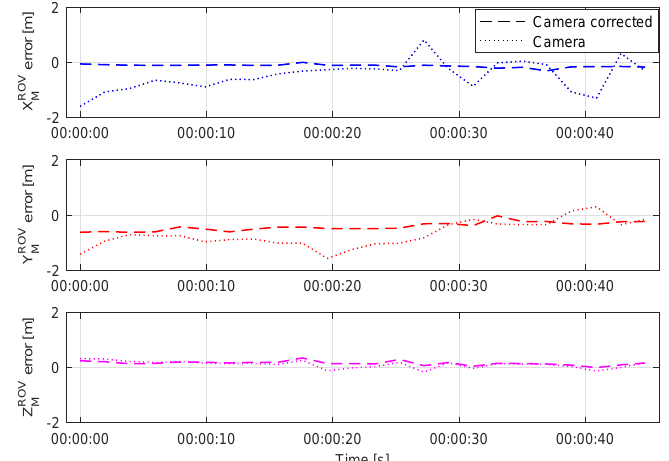
Figure 12. Relative position error of visually estimated pose before and after correction during the dynamic test.